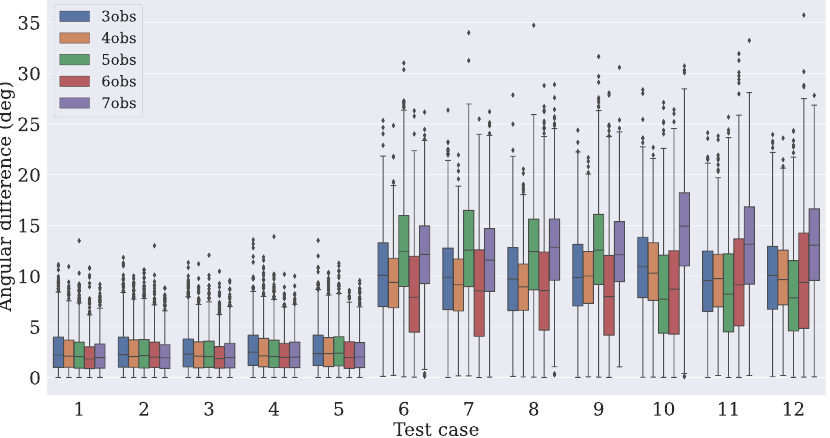
Figure 9. Dispersion of the absolute angular difference when using a dropout rate of 20%. Similarly, the model trained with 10% became more uncertain of its predictions as the testing dropout rate increased, as can be seen in Figure 11. The upper bound refers to the variance in the x -axis, the lower bound refers to the z -axis, and the dashed lines refer to the variance in the y